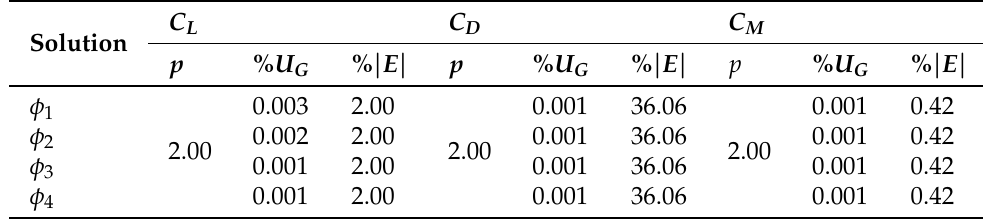
Table 24. Uncertainty estimations for C-mesh with varying wake node distributions (log 2, 1,0,1) based on mesh dependency. − −